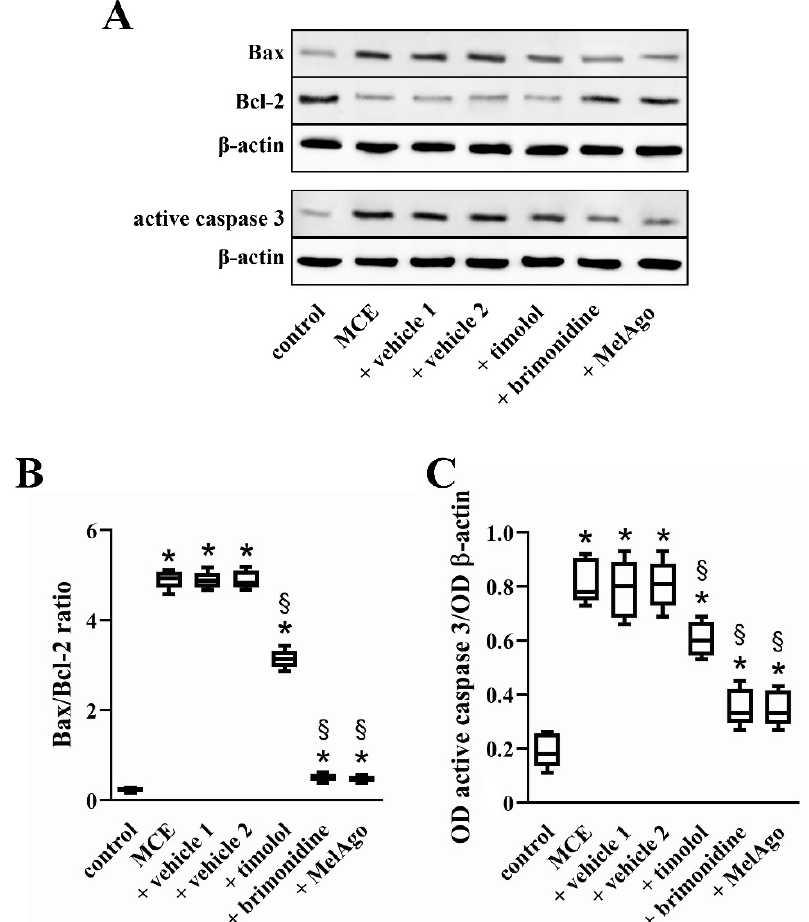
Figure 6. The Bax-caspase-3-dependent apoptotic pathway. ( A ) Representative Western blots from retinal homogenates of control rats or rats that received MCE, either untreated or treated with vehicles, timolol, brimonidine or melatonin / agomelatine. ( B , C ) Densitometric analysis of the levels of Bax / Bcl-2 ( B ) and active caspase 3 ( C ). MCE increased the Bax / Bcl-2 ratio and the level of active